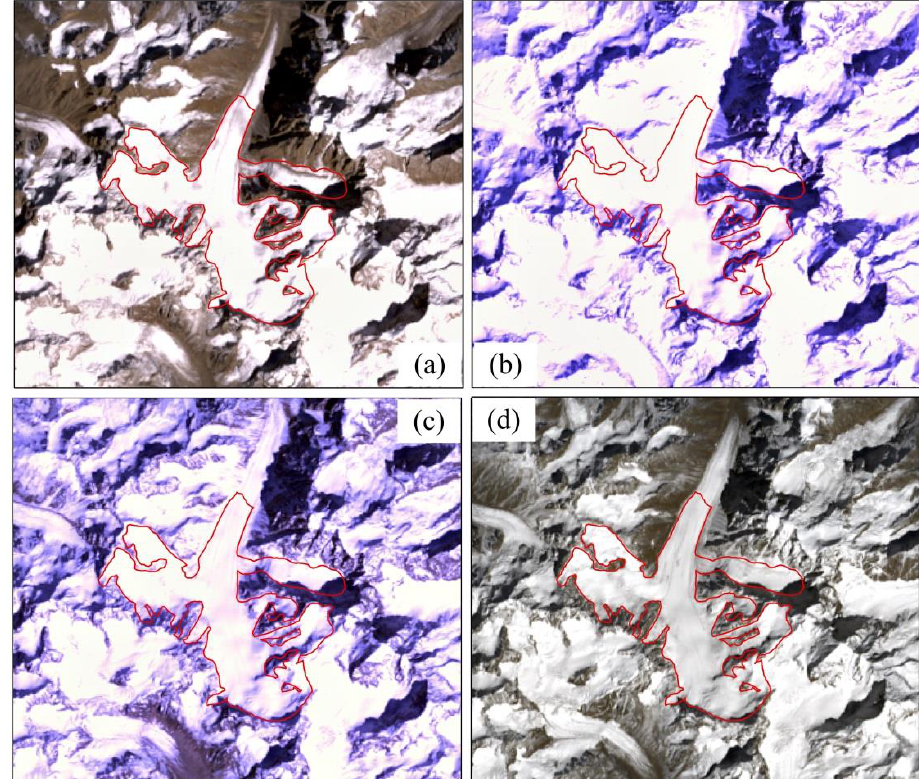
Figure 6. The original true-color Landsat images obtained on ( a ) 29 September 2000, ( b ) 27 September 2008, ( c ) 30 September 2009 and ( d ) 25 September 2013, respectively. In order to avoid any influence on the derivation of the satellite albedo, the pixels corresponding to debris-covered areas (<4600 m a.s.l.) were removed. The red solid lines here represent the debris-free zones in the Chhota Shigri glacier.